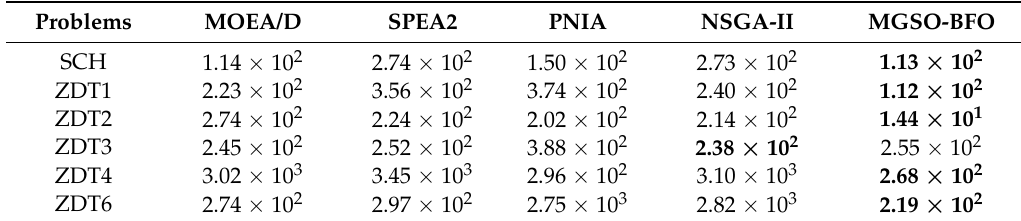
Table A3. The computation time of four different